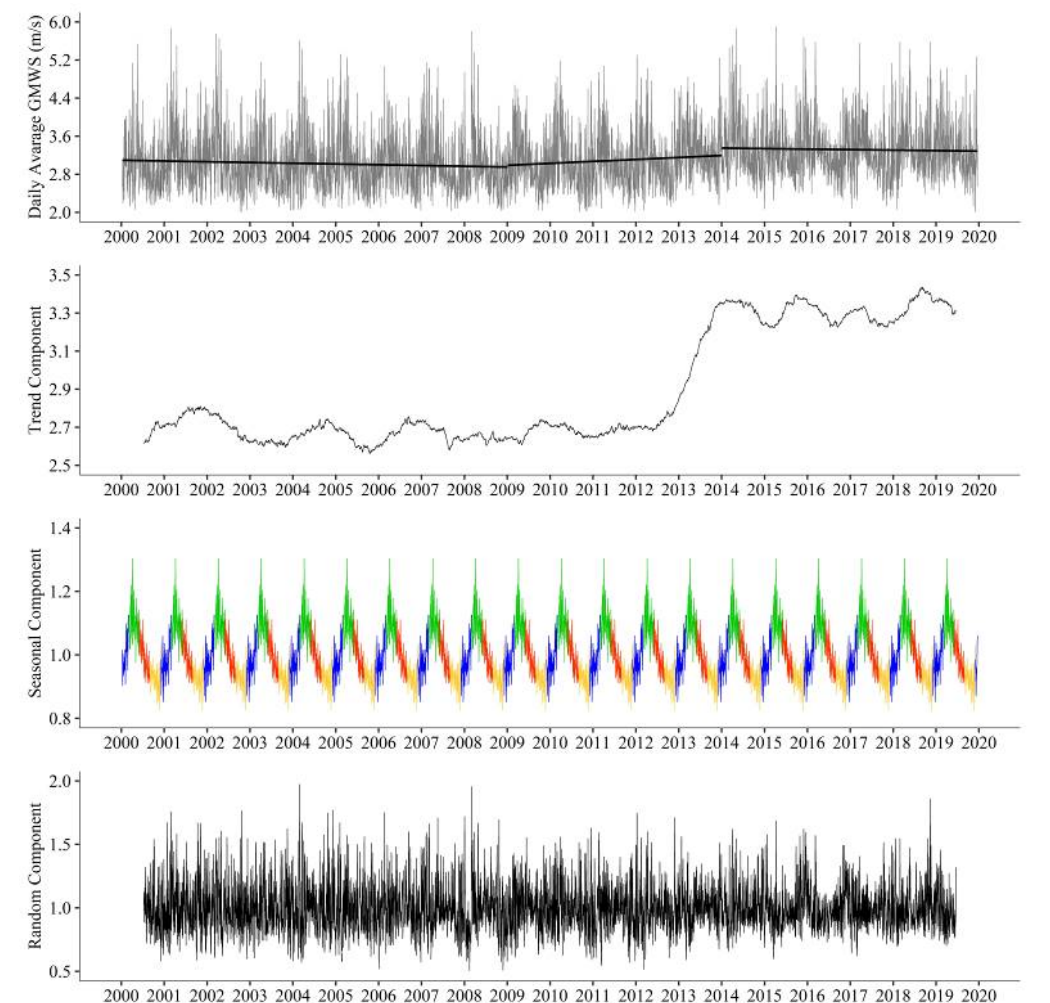
Figure 3. The time series decomposition of the average Ground Measurement Wind Speed (GMWS) in Central Asia (CA) from 2000 to 2019. Note: The di ff erent colors in the graph on the seasonal component indicate di ff erent seasons (blue: Winter (Dec., Jan., Feb.), green: Spring (Mar., Apr., May), red: Summer (Jun., Jul., Aug.), and yellow: Autumn (Sept., Oct.,